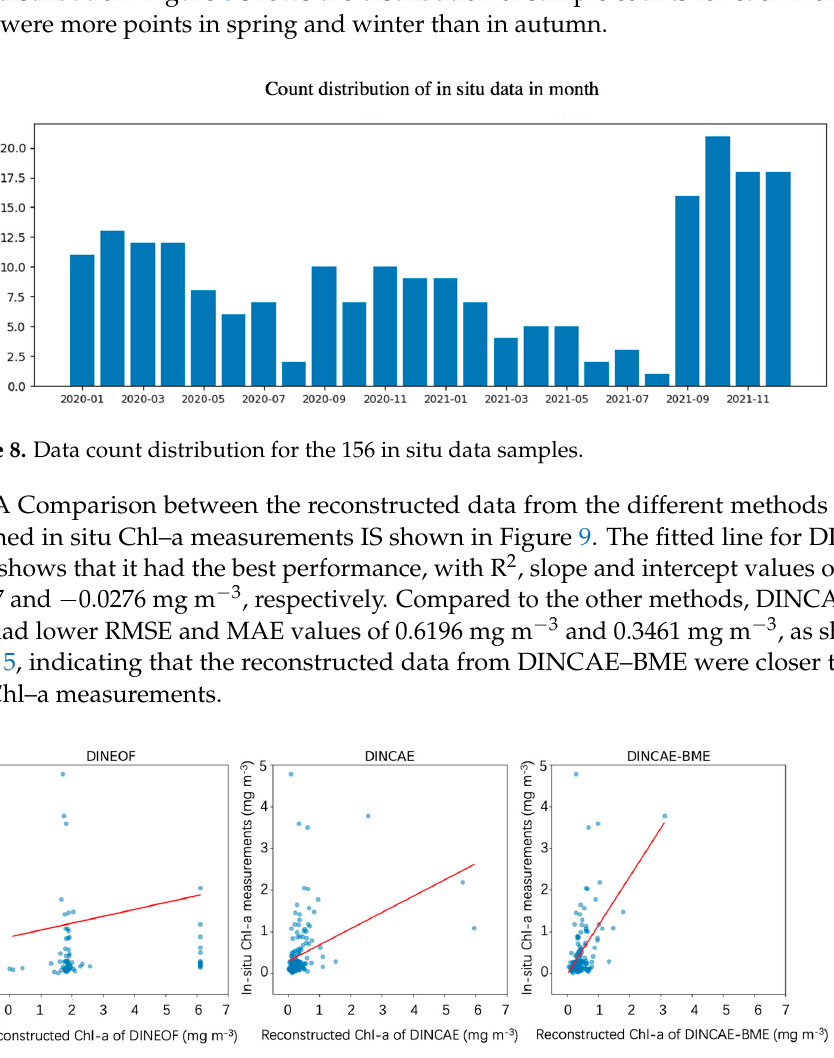
Figure 9. Comparison of the reconstructed data from different methods and in situ data. The match counts for DINEOF, DINCAE and DINCAE − BME were 74, 152 and 156. Table 5. Relationship between reconstructed values and corresponding in situ data.